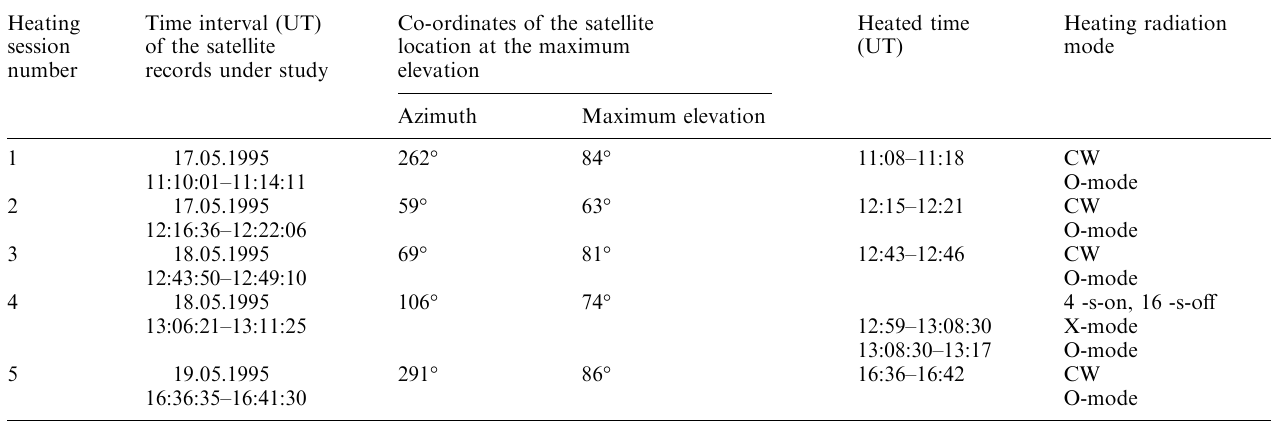
Table 1. Parameters of the satellite data and HF operation for the di(cid:128)erent sessions Heating Time interval (UT) session of the number